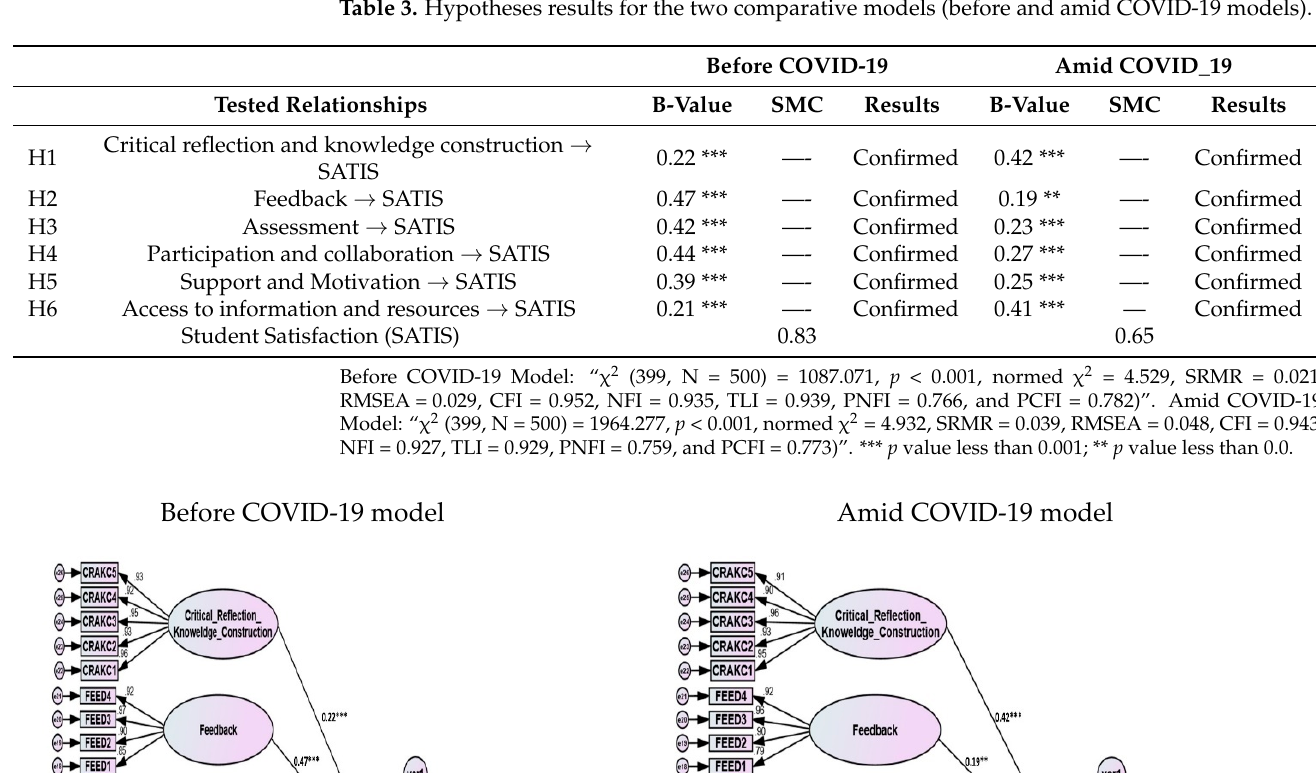
Table 3. Hypotheses results for the two comparative models (before and amid COVID-19 models).